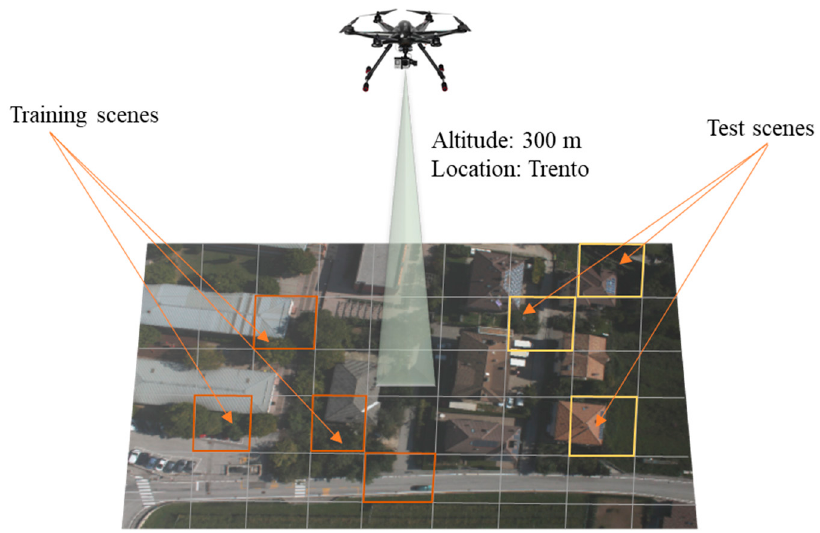
Figure 1. Standard supervised classification: training and test scenes are extracted from the same domain.